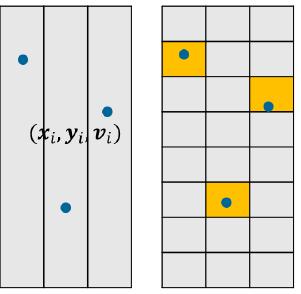
Figure 10. Left : Objects are represented by their position and velocity. Right : Objects are associated to a cell in an occupancy